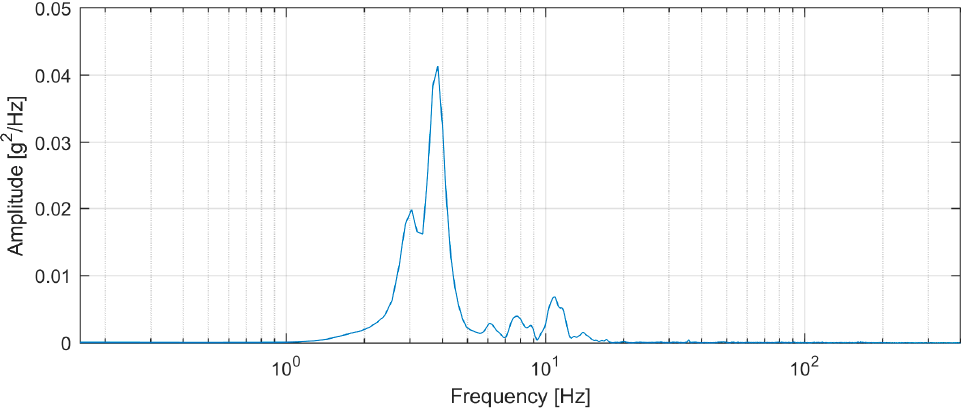
.. z FL av  FL z signal. av